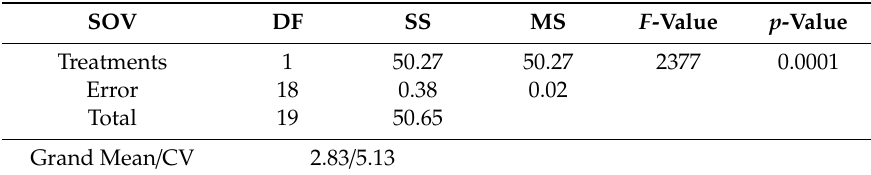
Table A15. Influence on the total amount of fresh weight per plant (g) of PeBL1-treated, and control cucumber seedlings.